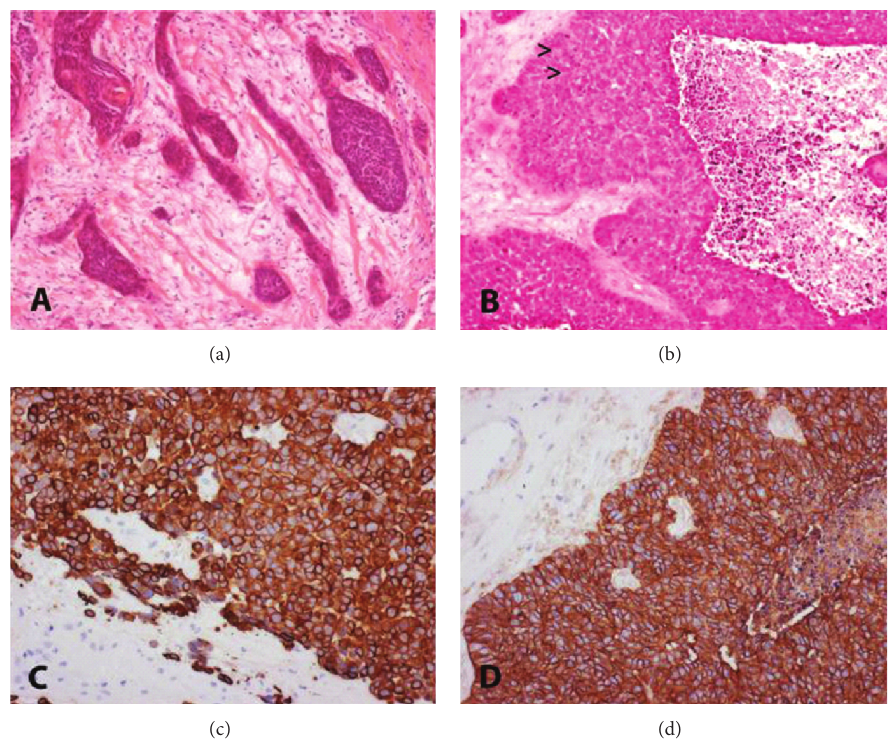
Figure 3: Histology and immunohistochemistry of OSCC, 5 𝜇 m thick serial sections of both primary tumor and cerebral metastasis were